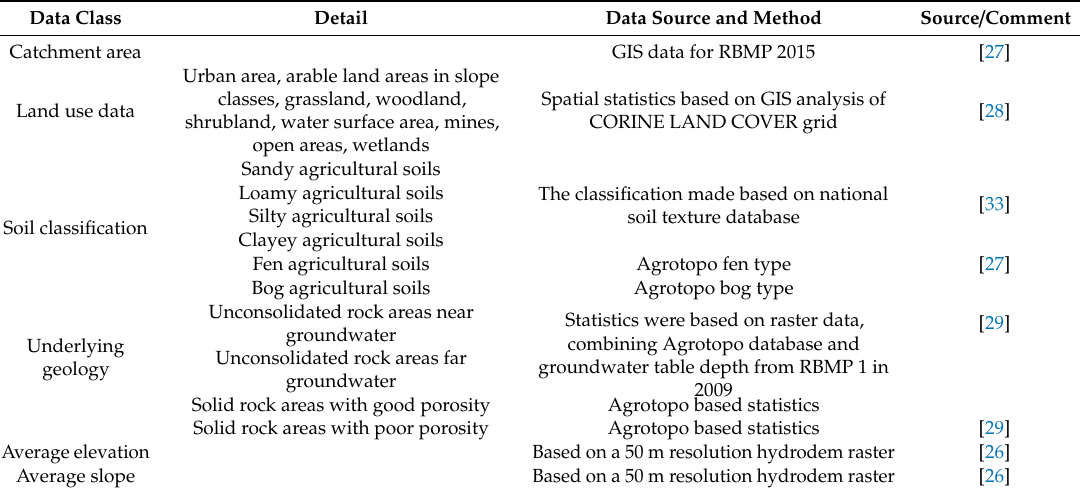
Table A1. Spatial data used for the MONERIS model input.